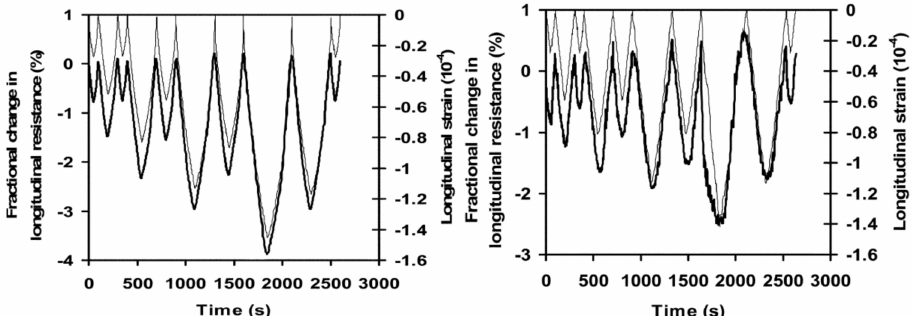
Figure 3. The fractional change in longitudinal resistance (thicker line) and longitudinal strain (thinner line) versus time for four-probe with embedded stainless-steel foils and four-probe connected on top